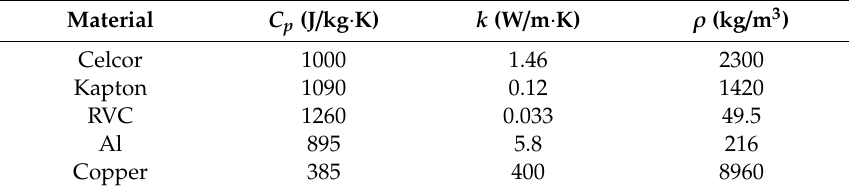
Table 3. Properties of various solid materials used in